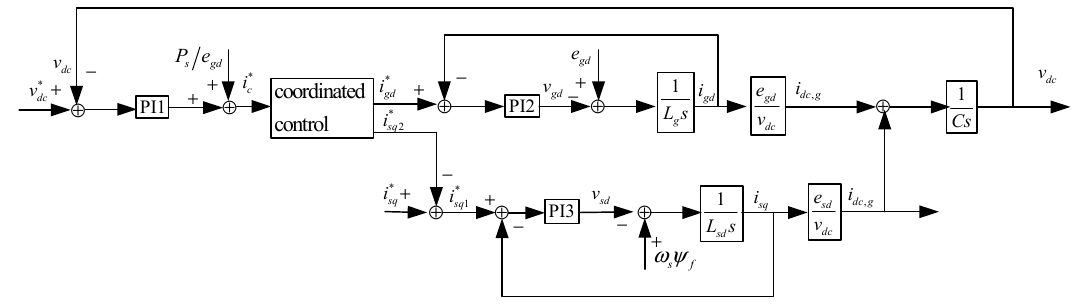
Figure 4. Simplified block diagram of the DC-link voltage control.